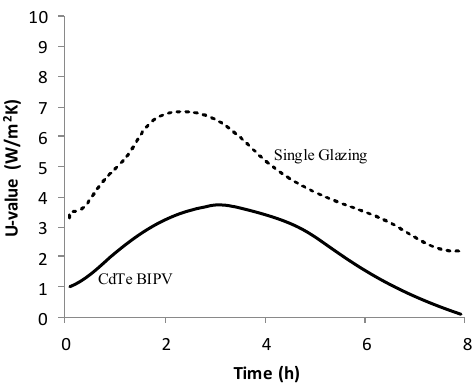
Figure 4. Overall heat transfer coefficient (U-value) of a CdTe BIPV window and a single glazed window–Indoor test [29].